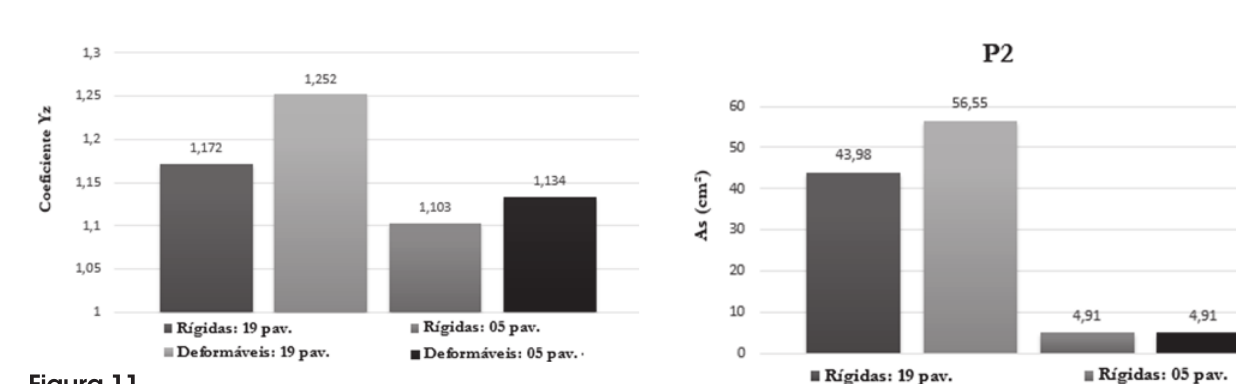
Figura 11 Modelo de Ferreira, El Debs e Elliot [1]: coeficiente